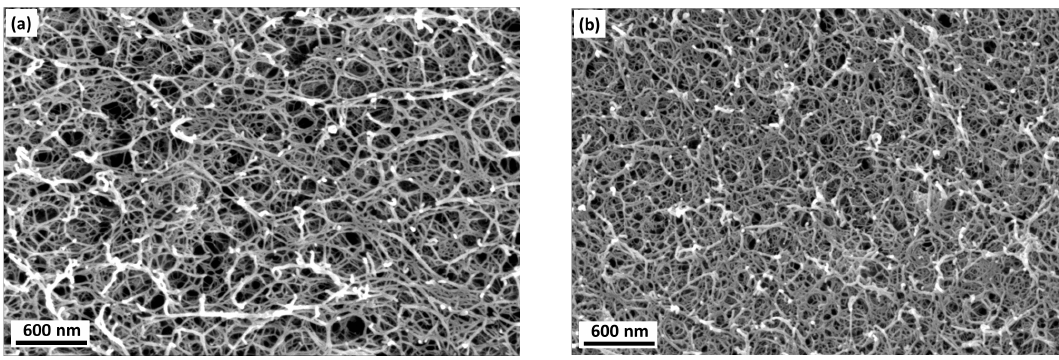
Figure 4. SEM images of k-carrageenan aerogels: ( a ) 1 wt. %, ( b ) 3 wt. % k-carrageenan